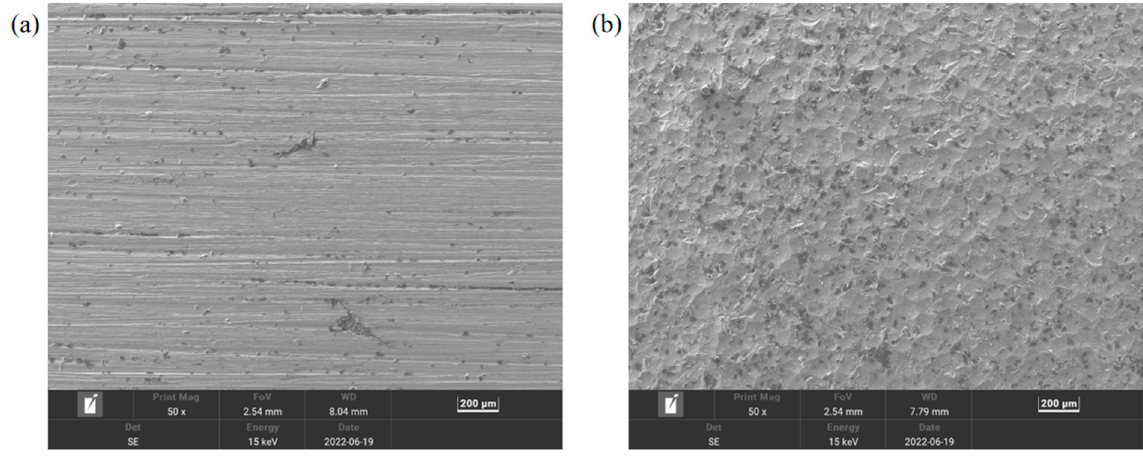
Figure 11. SEM images of the surfaces of ( a ) pristine Ni plate and ( b ) sandblasted Ni plate.